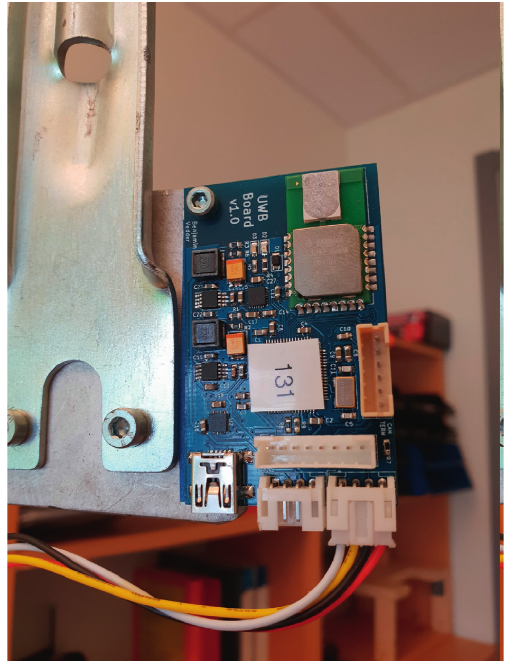
Figure 4: Our custom UWB module mounted on the model car and connected over CAN-bus. Power is also provided through the same connector.